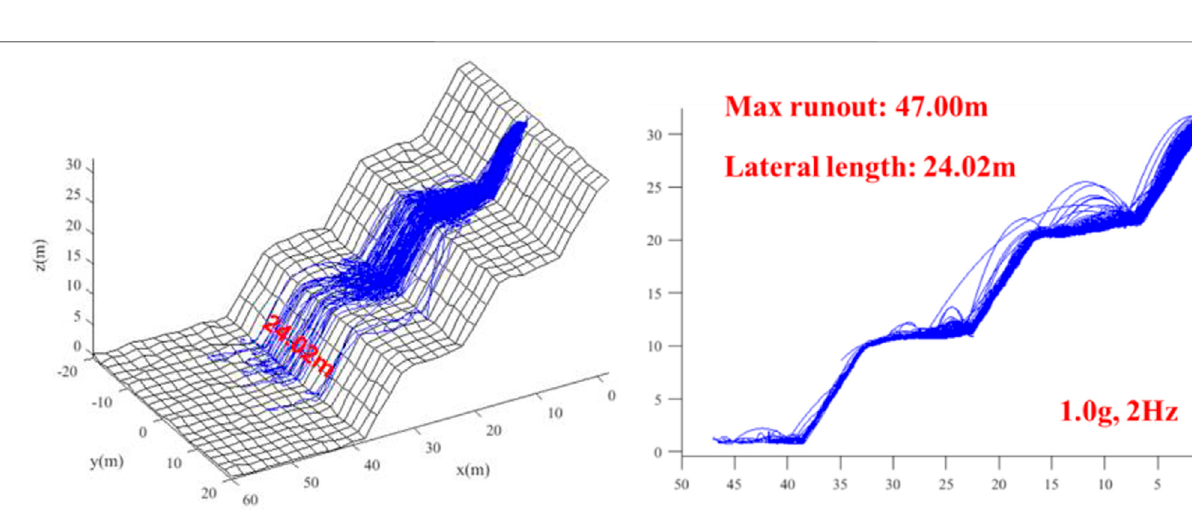
Frontiers in Earth Science |